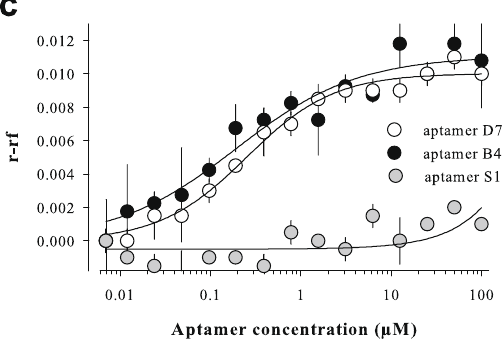
Figure 1. Toxin lethality and aptamer selection. ( a ) Dose-response curve illustrating α C-conotoxin PrXA- mediated mice death. i.p. and s.c. injection. ( b ) Shortening of the latency of death induction as a function of α C- conotoxin PrXA concentration. ( c ) Binding affinities of D7, B4 and S1 scramble aptamers towards 20 nM FAM- α C-conotoxin PrXA using fluorescence polarization. r: anisotropy of FAM- α C-conotoxin PrXA in presence of aptamer, rf: anisotropy of free FAM- α C-conotoxin